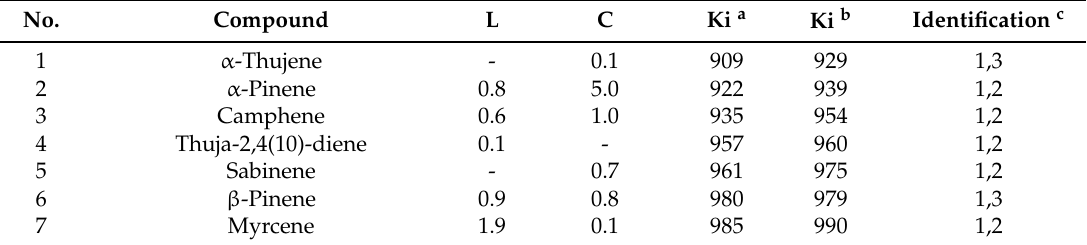
Table 1. Chemical composition of the essential oils of L. angustifolia (L) and C. sativum (C).